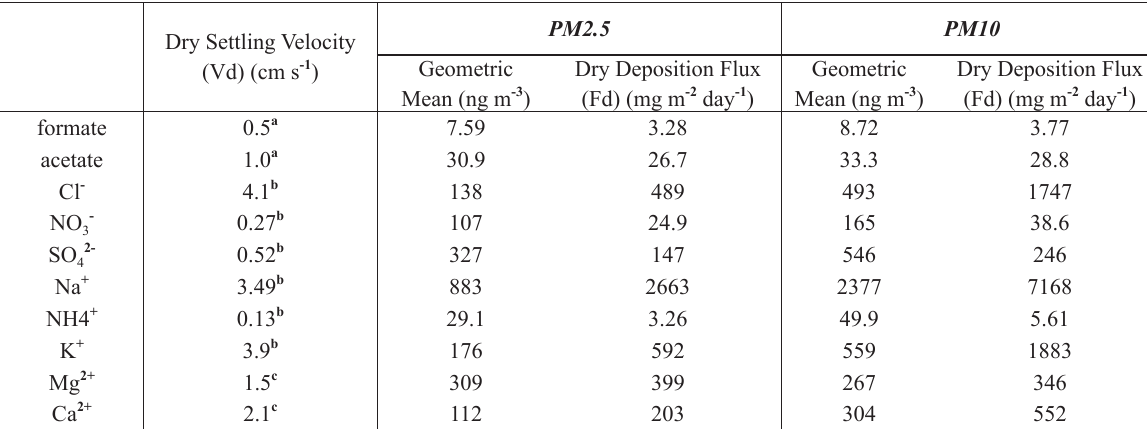
) for major ions in d